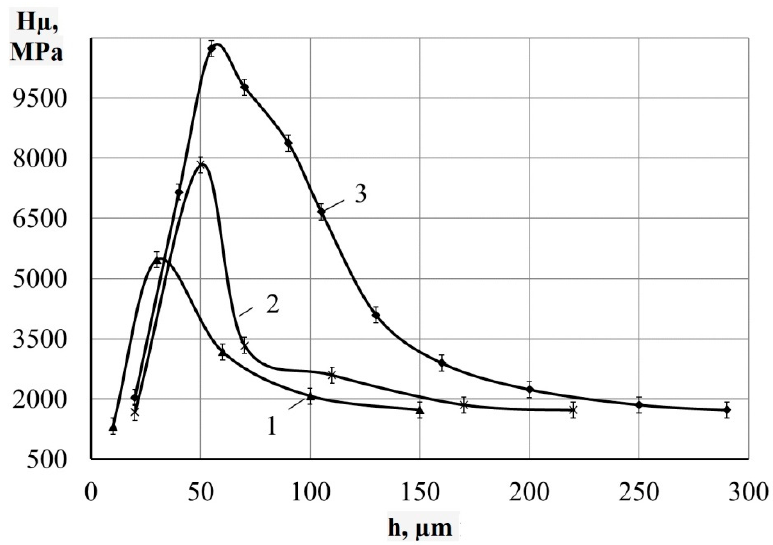
Figure 4. Microstructures in the surface layer of steel C40 after sulfomolybdenizing by ESA method: ( a ) Wp = 0.13 J; ( b ) Wp = 0.55 J; ( c ) Wp = 3.4 J.